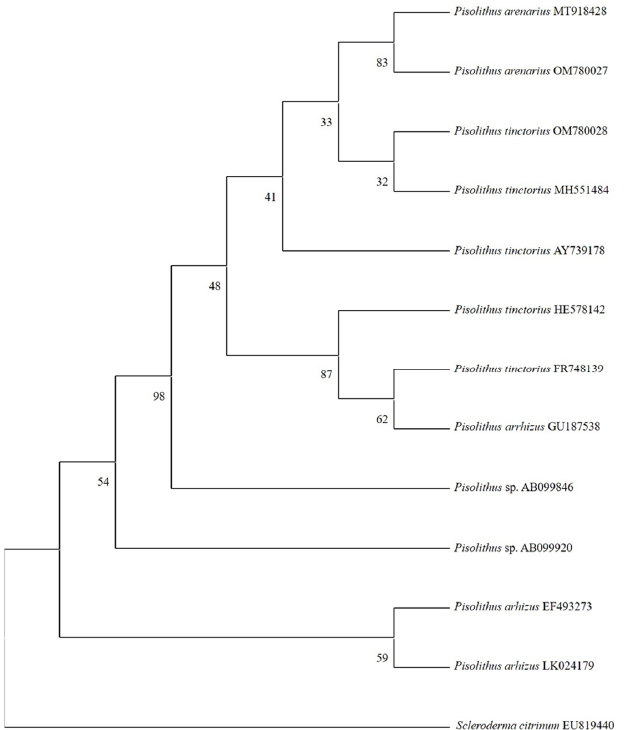
Figure 7. Phylogenetic tree of sequences constructed from DNA (ITS) to estimate relationships between species of Pisolithus . Pisolithus arenarius accession number OM780027 and Pisolithus tinctorius accession number OM780028 were the ECM of this study.